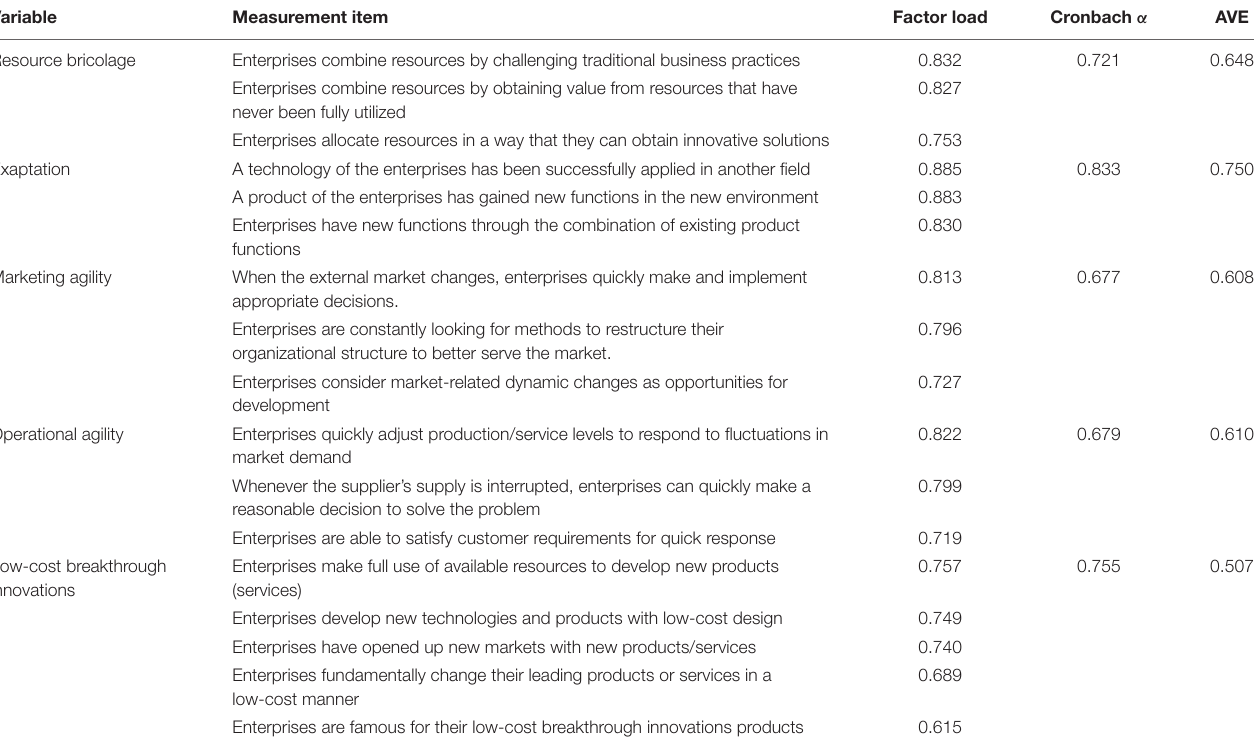
TABLE 1 | Factor analysis and the results of reliability and validity.